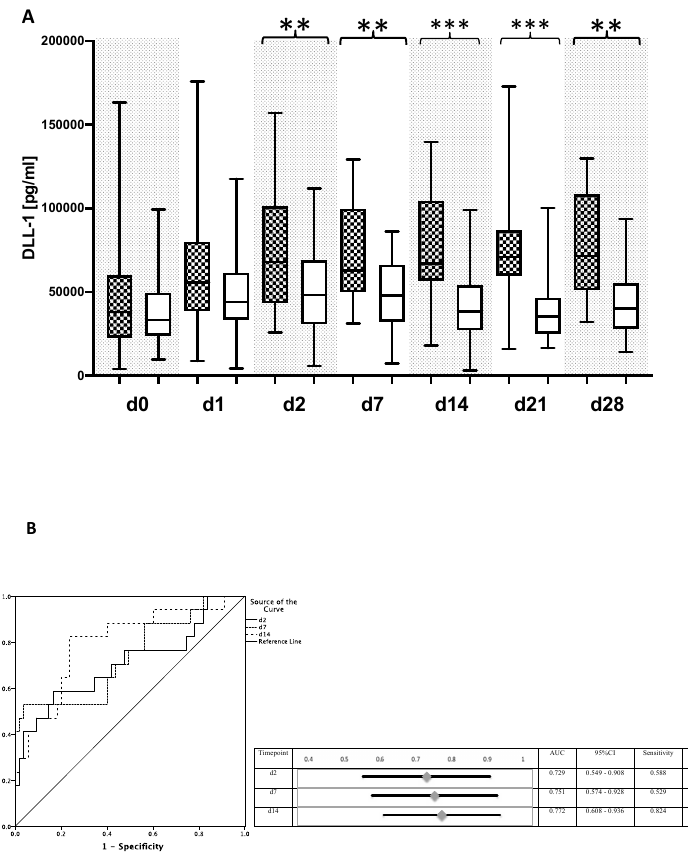
Figure 5. Delta-like Canonical notch ligand 1 (DLL1) for the prediction of a complicated course. ( A ) Plasma concentrations of Delta-like Canonical notch ligand 1 (DLL1) were measured in patients who suffered from two or more complications (rejection, liver failure, acute renal failure, acute lung injury) following LTX or died within 90 days after LTX (black checkered box) and in patients with less or no complications (white box). Plasma samples were collected directly after LTX and within the following 28 days afterwards on the indicated day. Data presentation: box plots with median, 25th percentile and 75th percentile in the box, as well as with the 10th and 90th percentiles at the end of the whiskers. Symbols of significance: p < 0.01: **, p < 0.001 ***. ( B ) Receiver operating characteristic (ROC) analysis in all patients regarding the value of DLL1 for the prediction of a complicated course on day 2, day 7, and day 14 after LTX. Patients with two or more complications up to day 28 or death within 90 days represented the target group, whereas the remaining patients were defined as controls.